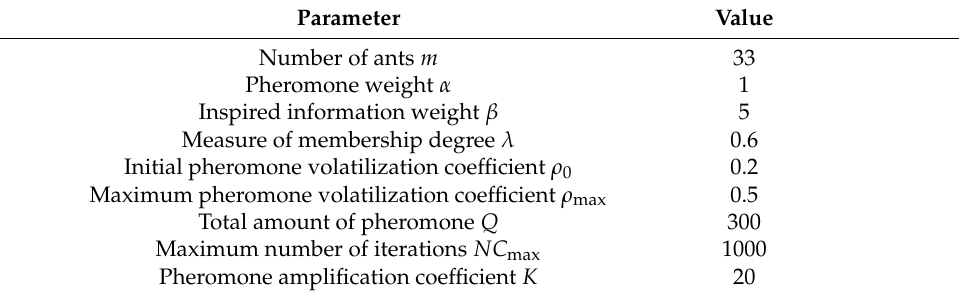
Table 3. Parameter settings of our proposed ACO algorithm.